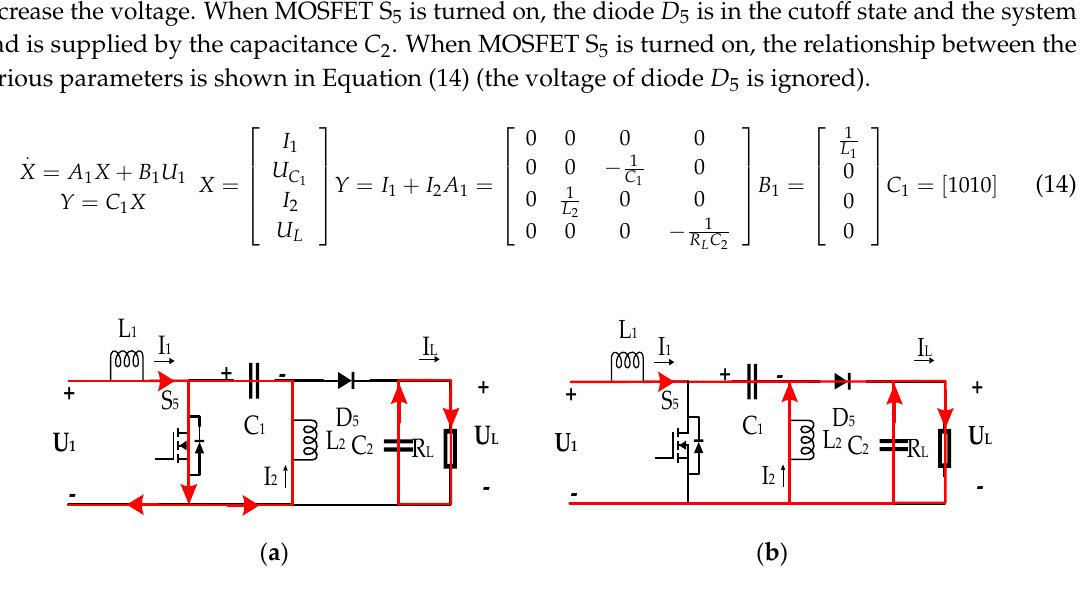
5 is turned on; and ( b ) MOSFET S 5 is turned